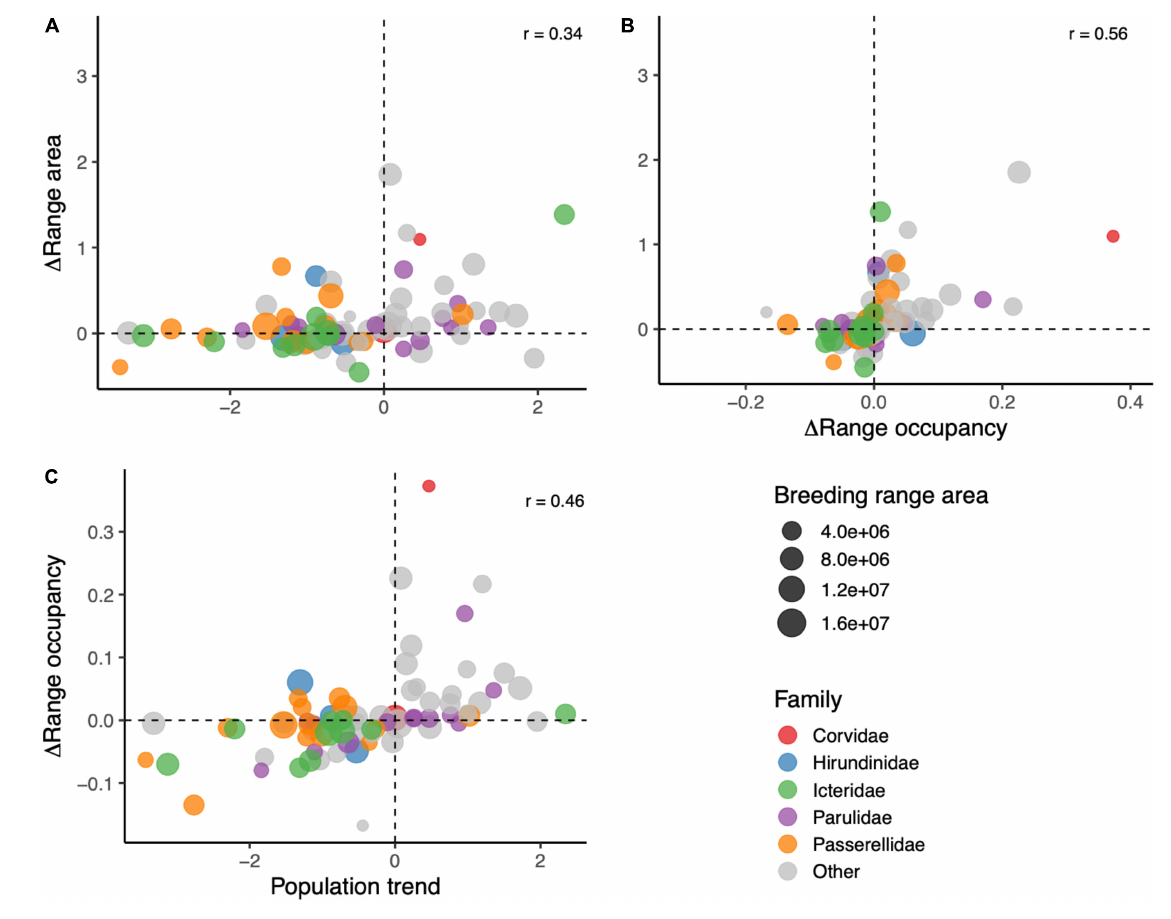
FIGURE3 Cross-correlations of different measurements of changes in species distributions over time. (A) Compares relative change in range area and population trend (%/year), (B) compares relative change in range area and absolute change in range occupancy, and (C) compares absolute change in range occupancy and population trend. Each species dot is sized by the size of the species breeding range, and colored by